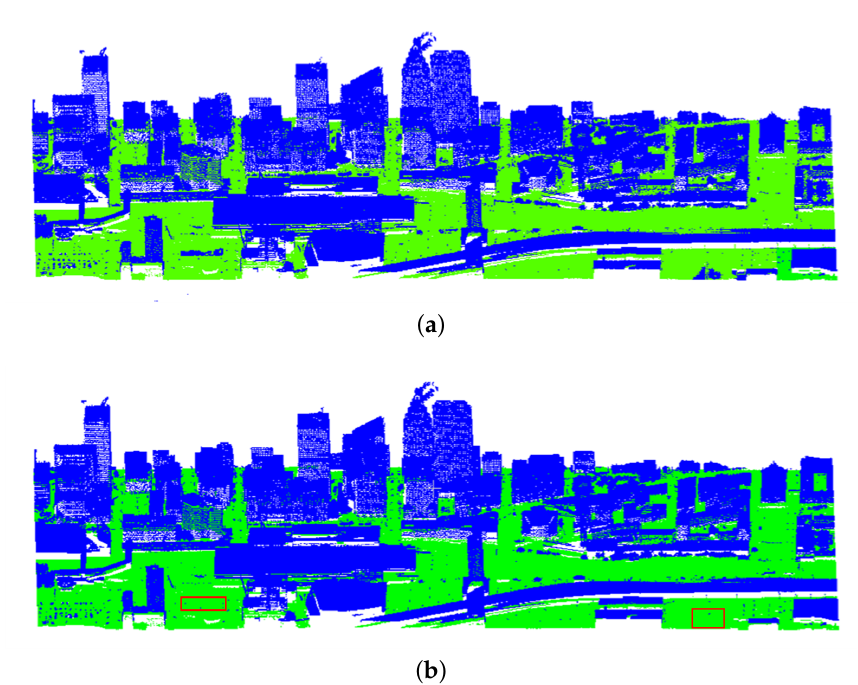
Figure 7. The result of the proposed method. ( a ) The point cloud manually labeled. ( b ) The point cloud processed by the proposed method. The red box area in ( b ) is classified incorrectly.